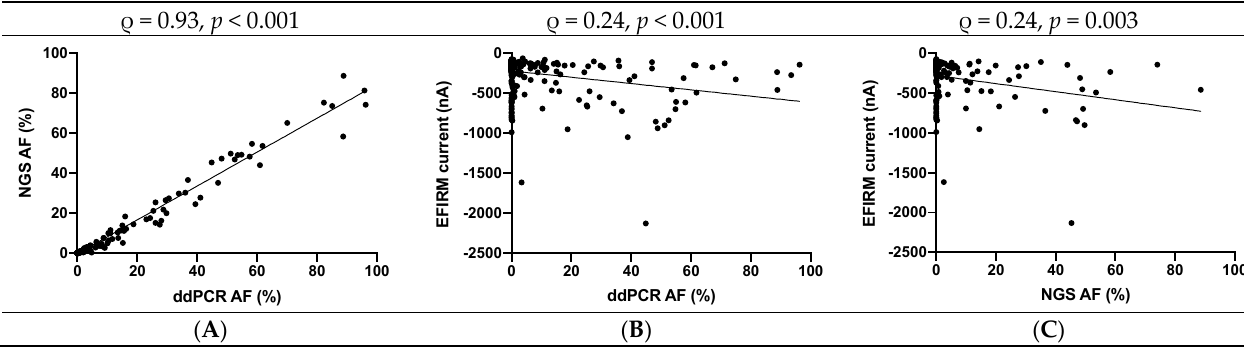
RECIST 1.1 progression, ctDNA progression predated RECIST 1.1 progression by a median of 118 days (range: 61–272 days) in 11 (55%) patients. NGS and eLB also showed similar patterns of ctDNA rise before radiographic progression. Of the nine patients without ctDNA progression by ddPCR, two patients had an increase in EGFR mutation-level by eLB (LAT006, LAT026) and two patients were found to have ctDNA progression by NGS (increase in PTEN Y88* AF in LAT007 and increase in TP53 V157F in LAT016). In 5 patients, ctDNA progression did not precede RECIST 1.1 progression (LAT011, LAT020, LAT021, LAT022, LAT025; Supplementary Figure S2); ctDNA progression lagged radiographic RECIST 1.1 progression in two patients (12 days for LAT011, 10 days for LAT021). In one patient